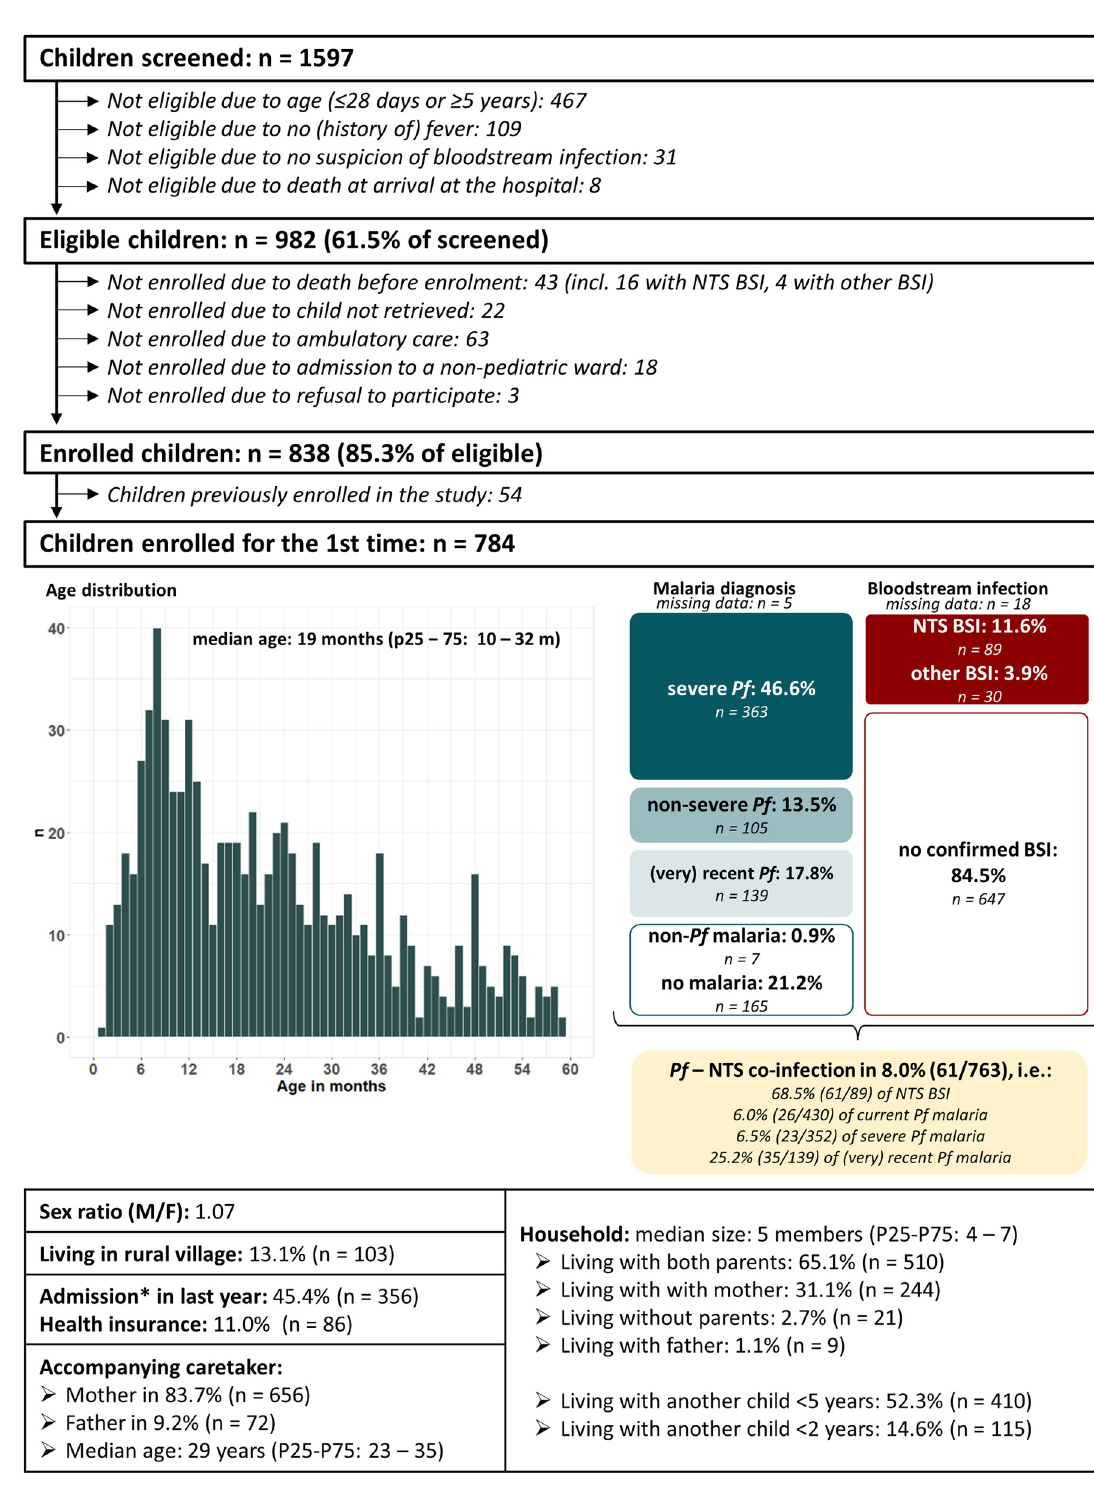
Fig 2. Flowchart of study enrolment and overview of sociodemographic and diagnostic characteristics of study population. Abbreviations: BSI: bloodstream infection; NTS: non-typhoidal Salmonella; Pf : Plasmodium falciparum . � An admission in the last year was defined as minimum one overnight stay in a registered or private health centre or a hospital, preceding the fever onset of the current disease episode.